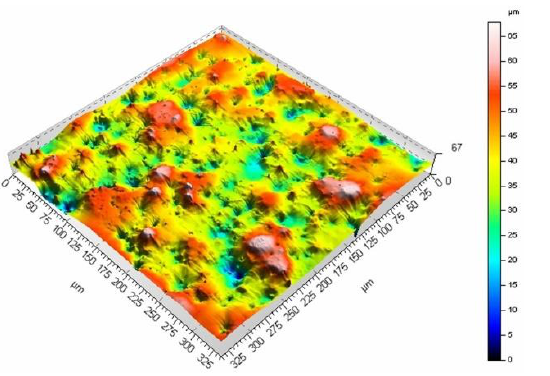
Figure 10. Surface morphology produced from a pulse duration of 60 ns and velocity of 200 mm/s.